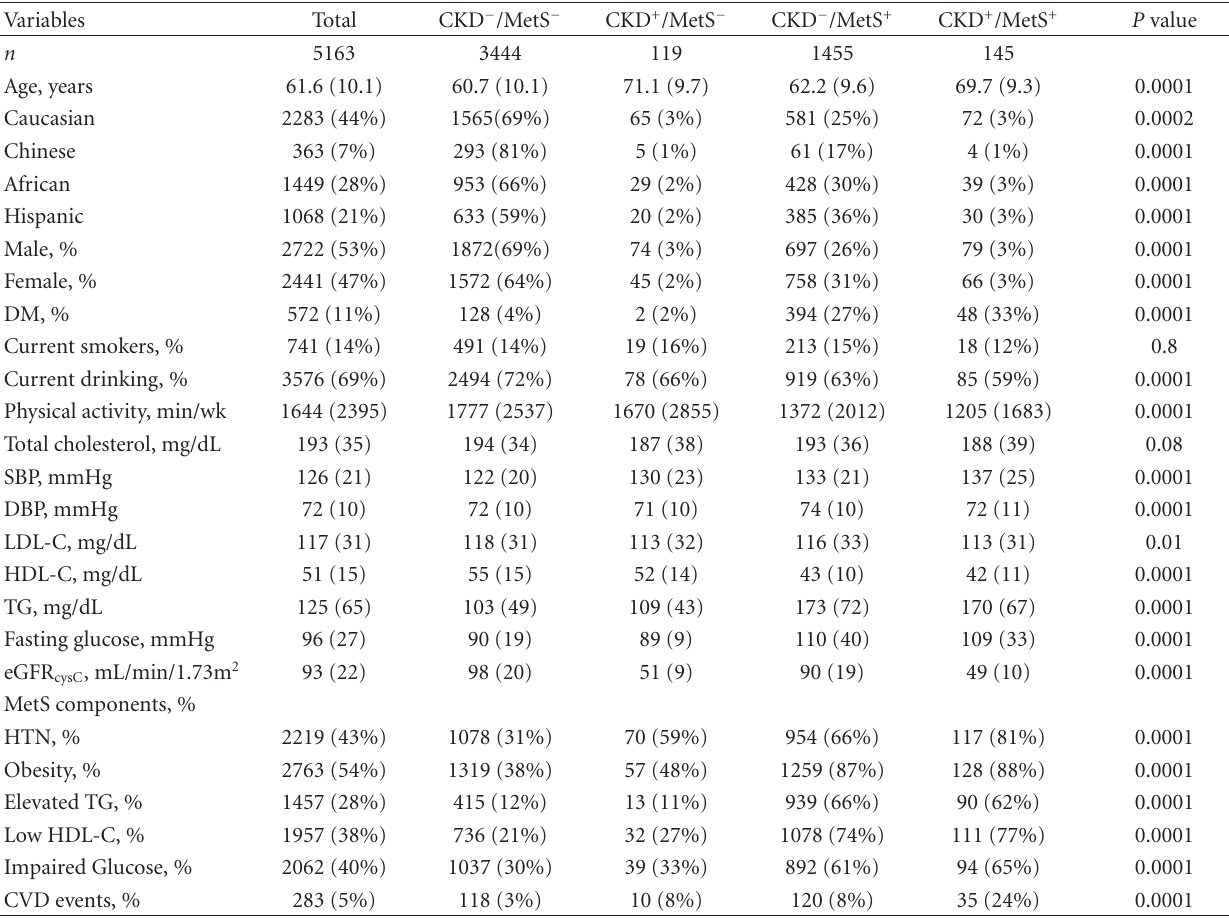
Table 1: Baseline characteristics of study participants in the MESA cohort at baseline (2000).